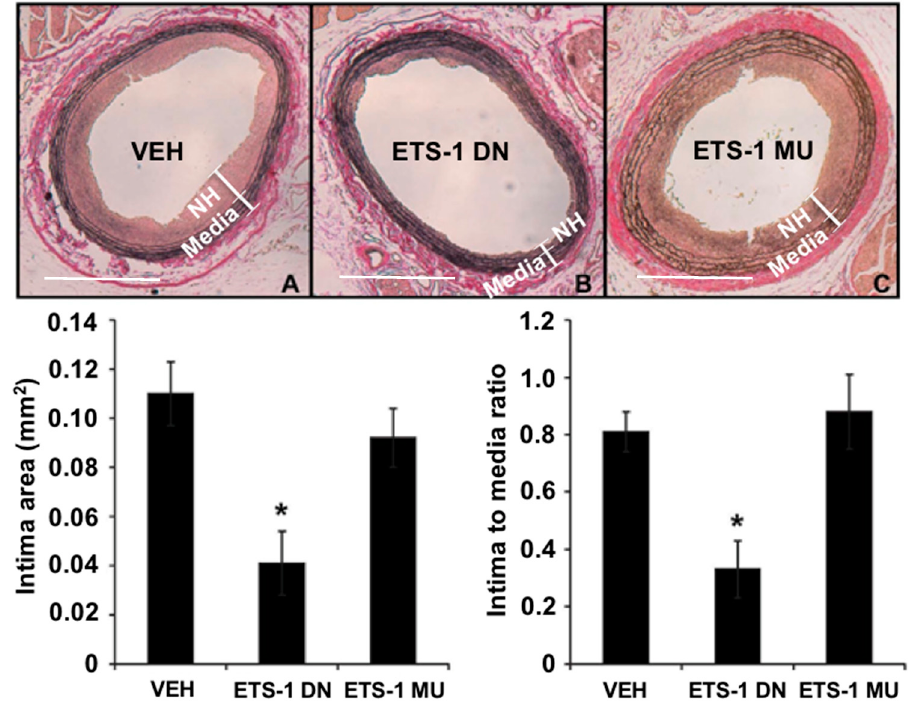
Figure 4. A single injection of ETS-1 DN (10 mg/kg) inhibited the formation of neointimal hyperplasia (NH) in injured rat carotid arteries. Top, elastic Van Gieson-stained tissue sections of carotid arteries from rats treated with ( A ) saline vehicle (VEH); ( B ) ETS-1 DN; or ( C ) ETS-1 mutant (MU) 14 days after balloon injury. Bottom, composite data are shown as mean ± SEM ( n = 6 per group). * p < 0.05 compared to the VEH group. (Bar = 50 μ m).